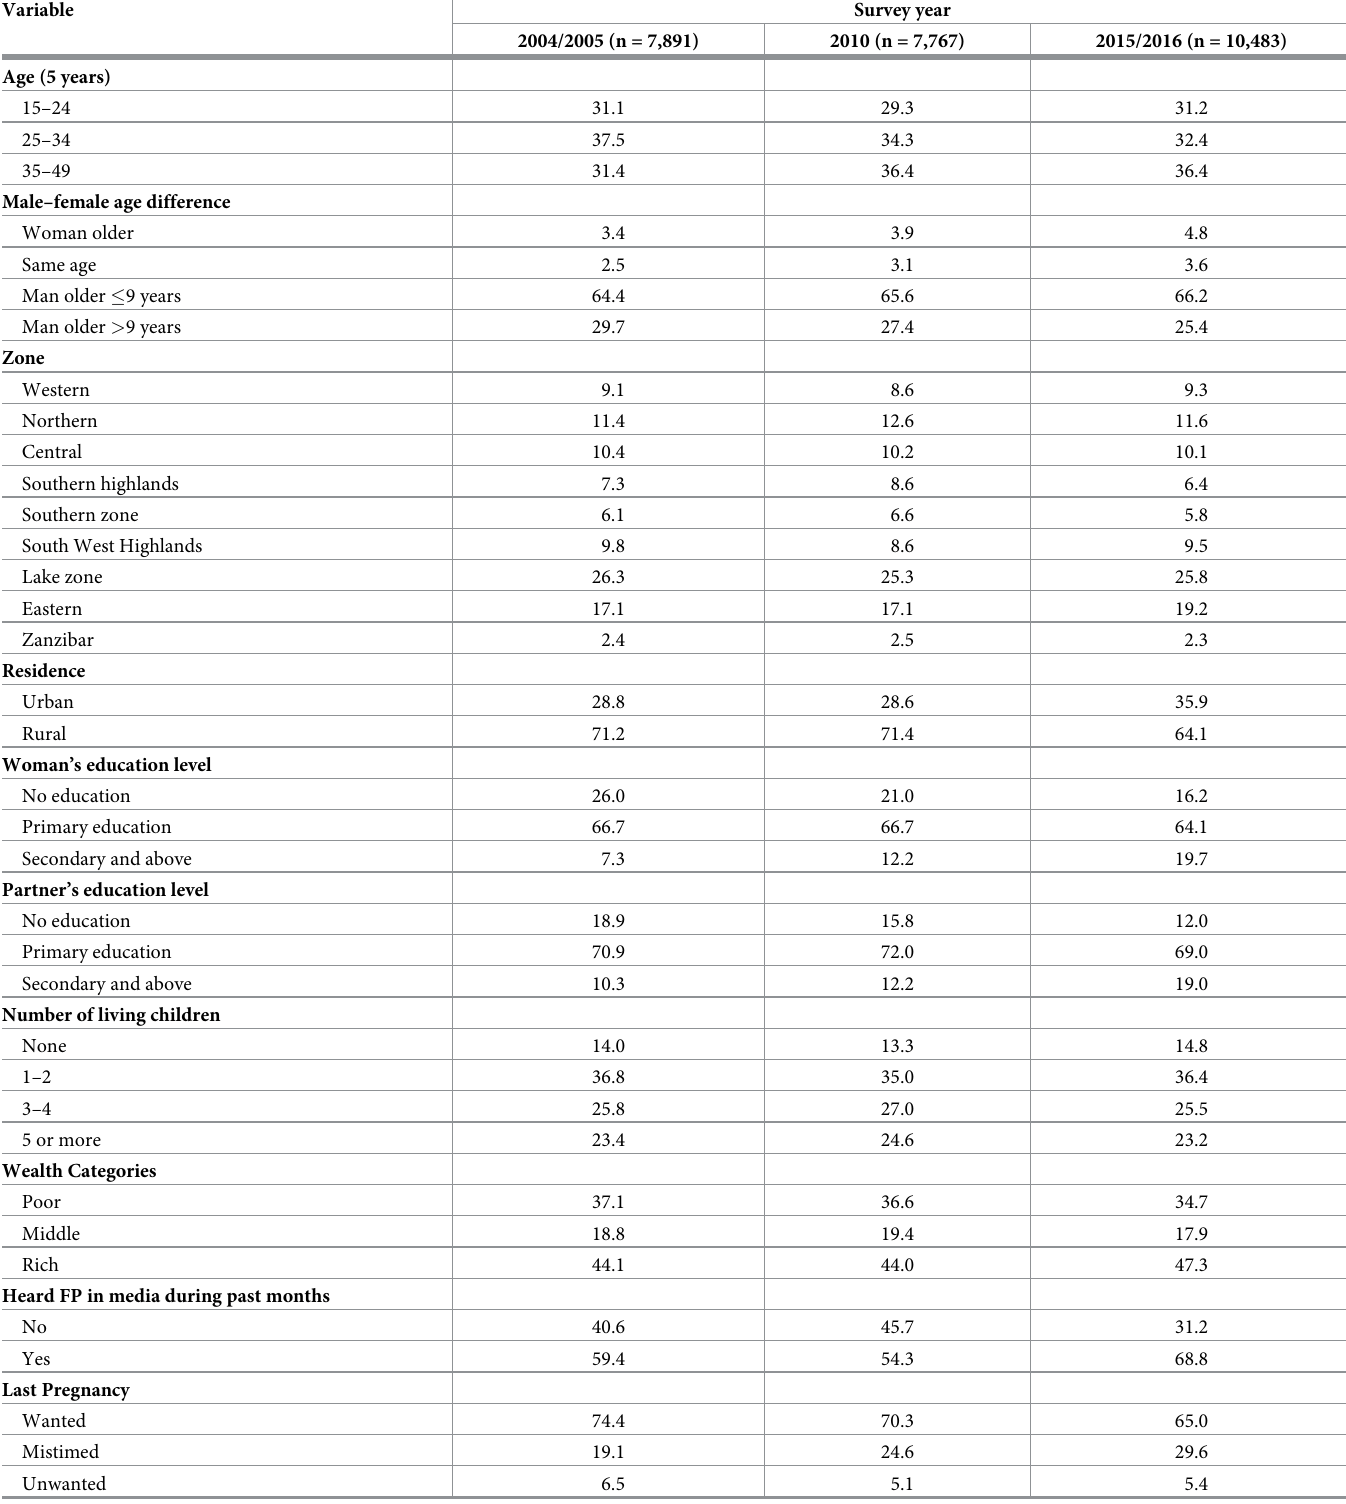
Table 1. Background characteristics (weighted) of study participants in the TDHS 2004/2005, 2010 and 2015/2016 surveys (N =